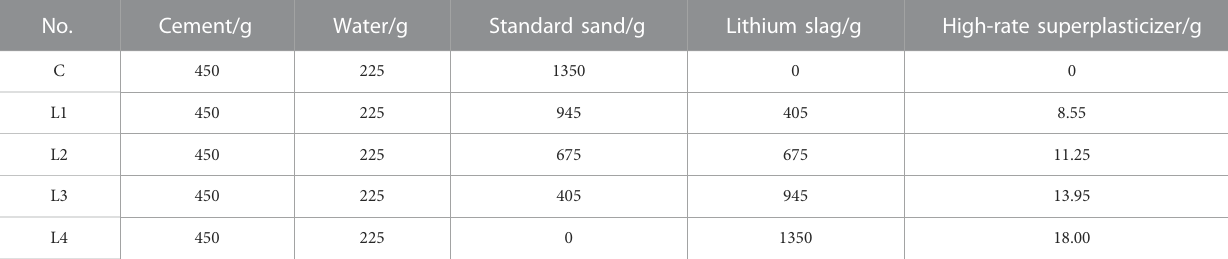
TABLE 2 Mix of cement – lithium slag